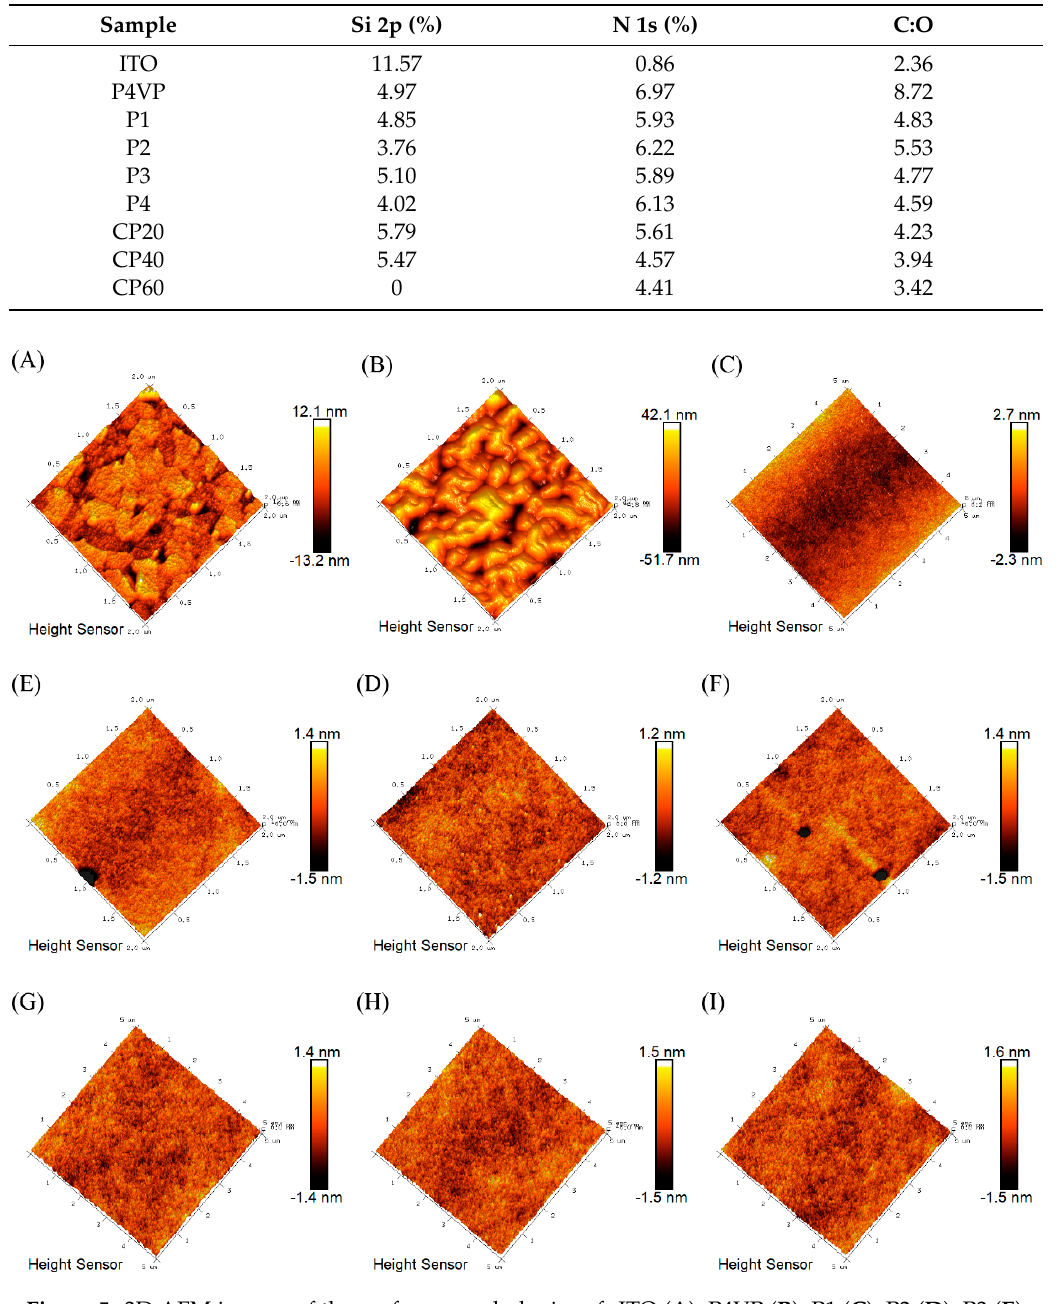
Figure 5. 3D AFM images of the surface morphologies of: ITO ( A ), P4VP ( B ), P1 ( C ), P2 ( D ), P3 ( E ), P4 ( F ), CP20 ( G ), CP40 ( H ) and CP60 ( I